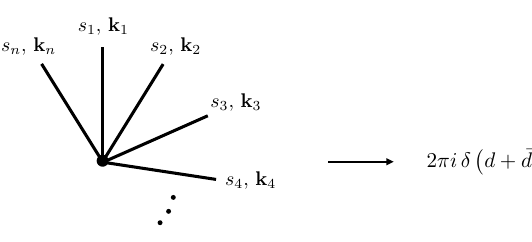
Figure 8. In the Mellin-Barnes representation of diagrams contributing boundary correlators in (EA)dS, in addition to Dirac delta functions enforcing conservation of boundary momenta k i at each vertex, the Dilatation symmetry of (EA)dS requires that there is a Dirac delta function enforcing that the Mellin variables s i associated to each line add up to a constant. This constant depends on the boundary dimension d and a parameter ¯ d which is sensitive to spin of the fields meeting at the vertex and the number of